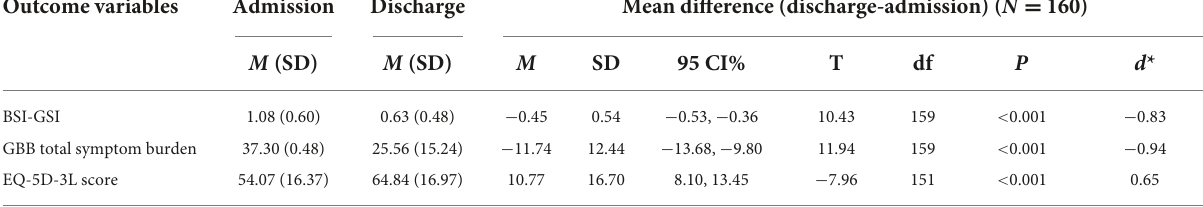
TABLE 2 Changes in psychological scale scores at discharge compared to admission (paired t -tests, N = 160). Outcome variables